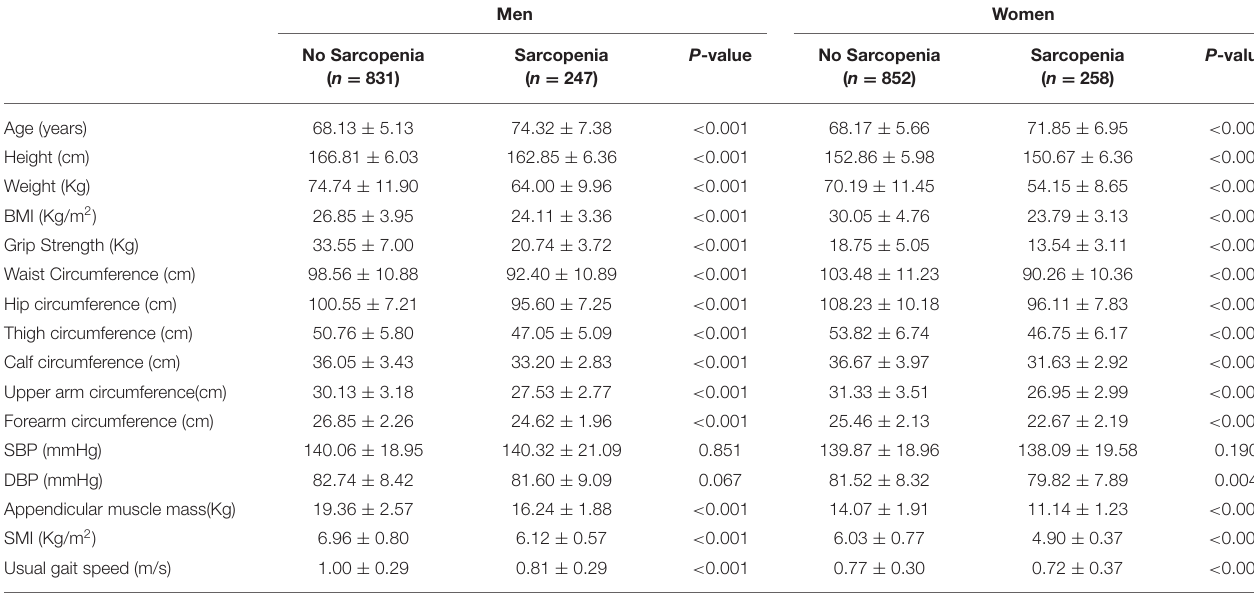
TABLE 1 | Characteristics of study population.